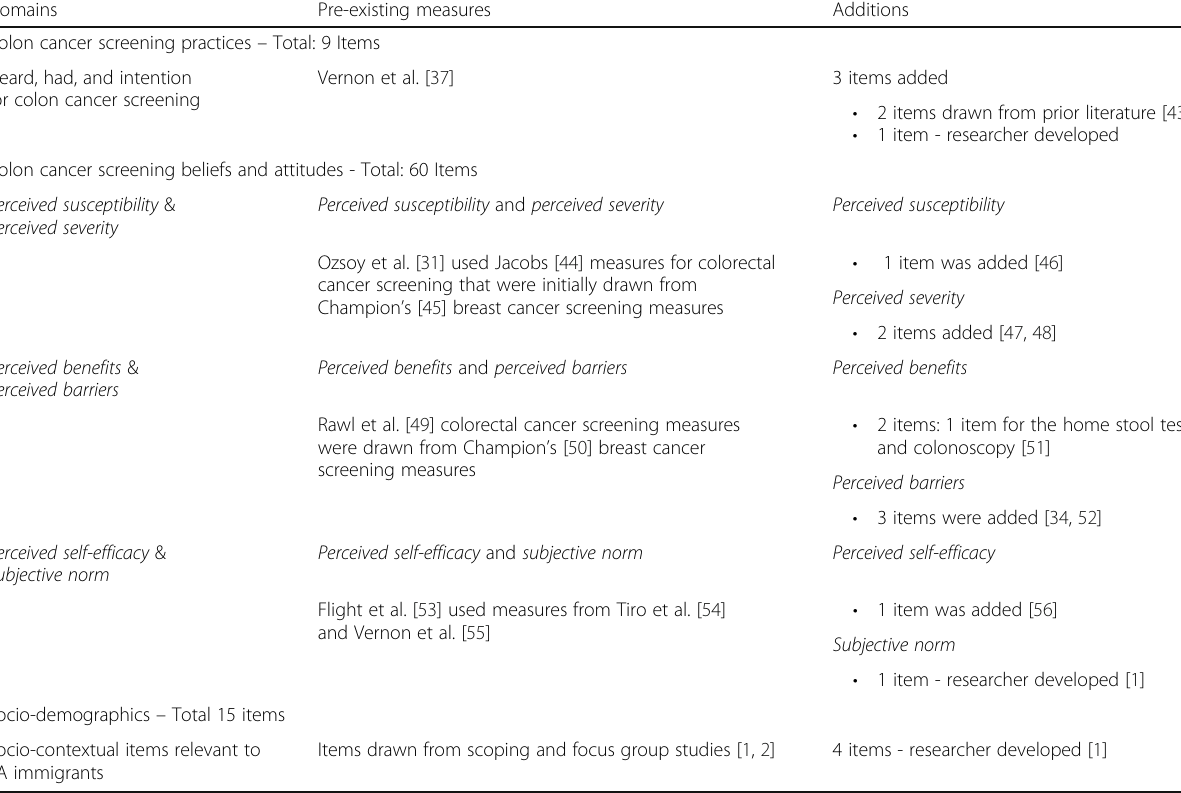
Table 1 Summary of Measures in the Survey Domains Pre-existing